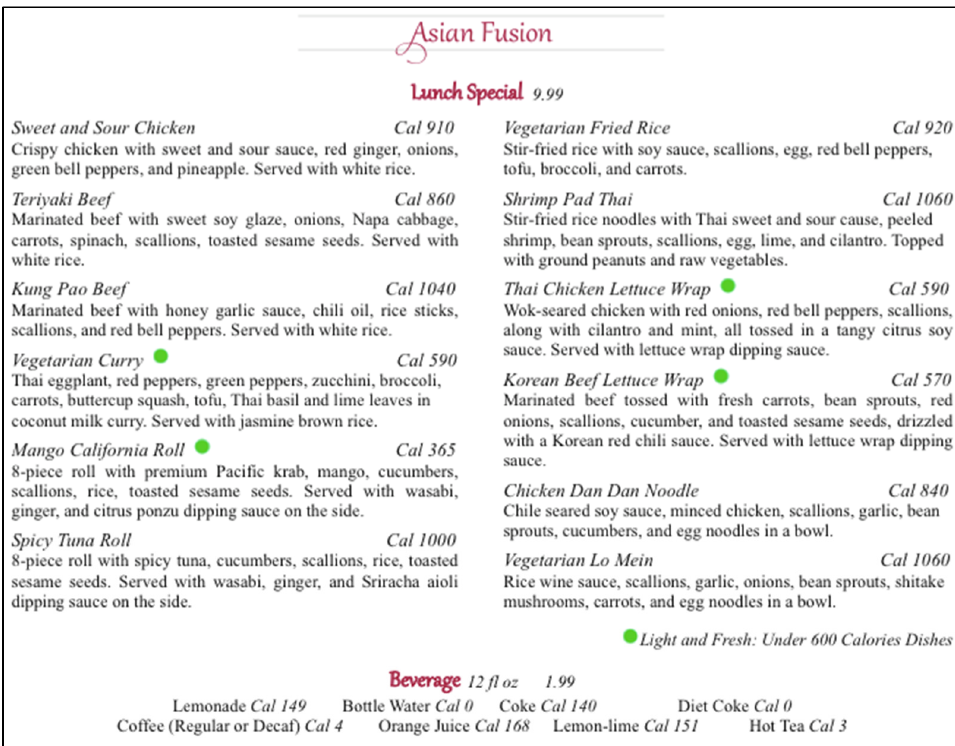
Figure A4. Asian Fusion Light and Fresh Menu.